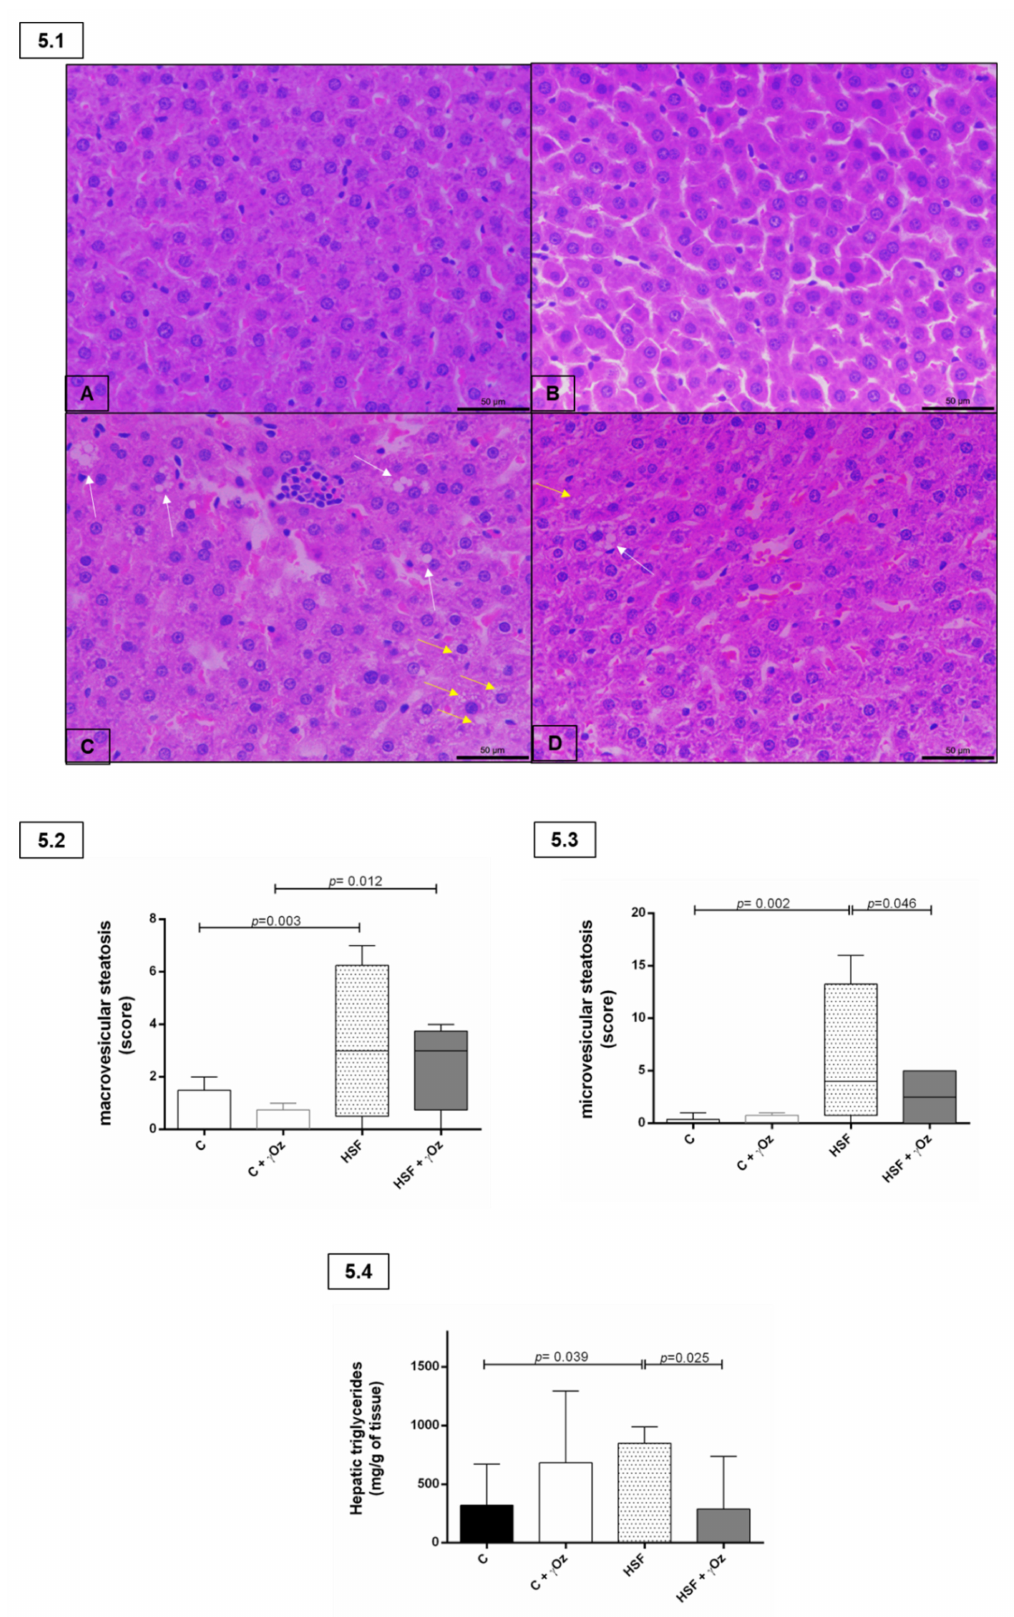
Figure 5. Hepatic steatosis analysis. ( 5.1 ) Histology of liver tissue using Hematoxylin and Eosin. ( A )— Illustrative image (40 × magnification) of control group. ( B )—Illustrative image (40 ×